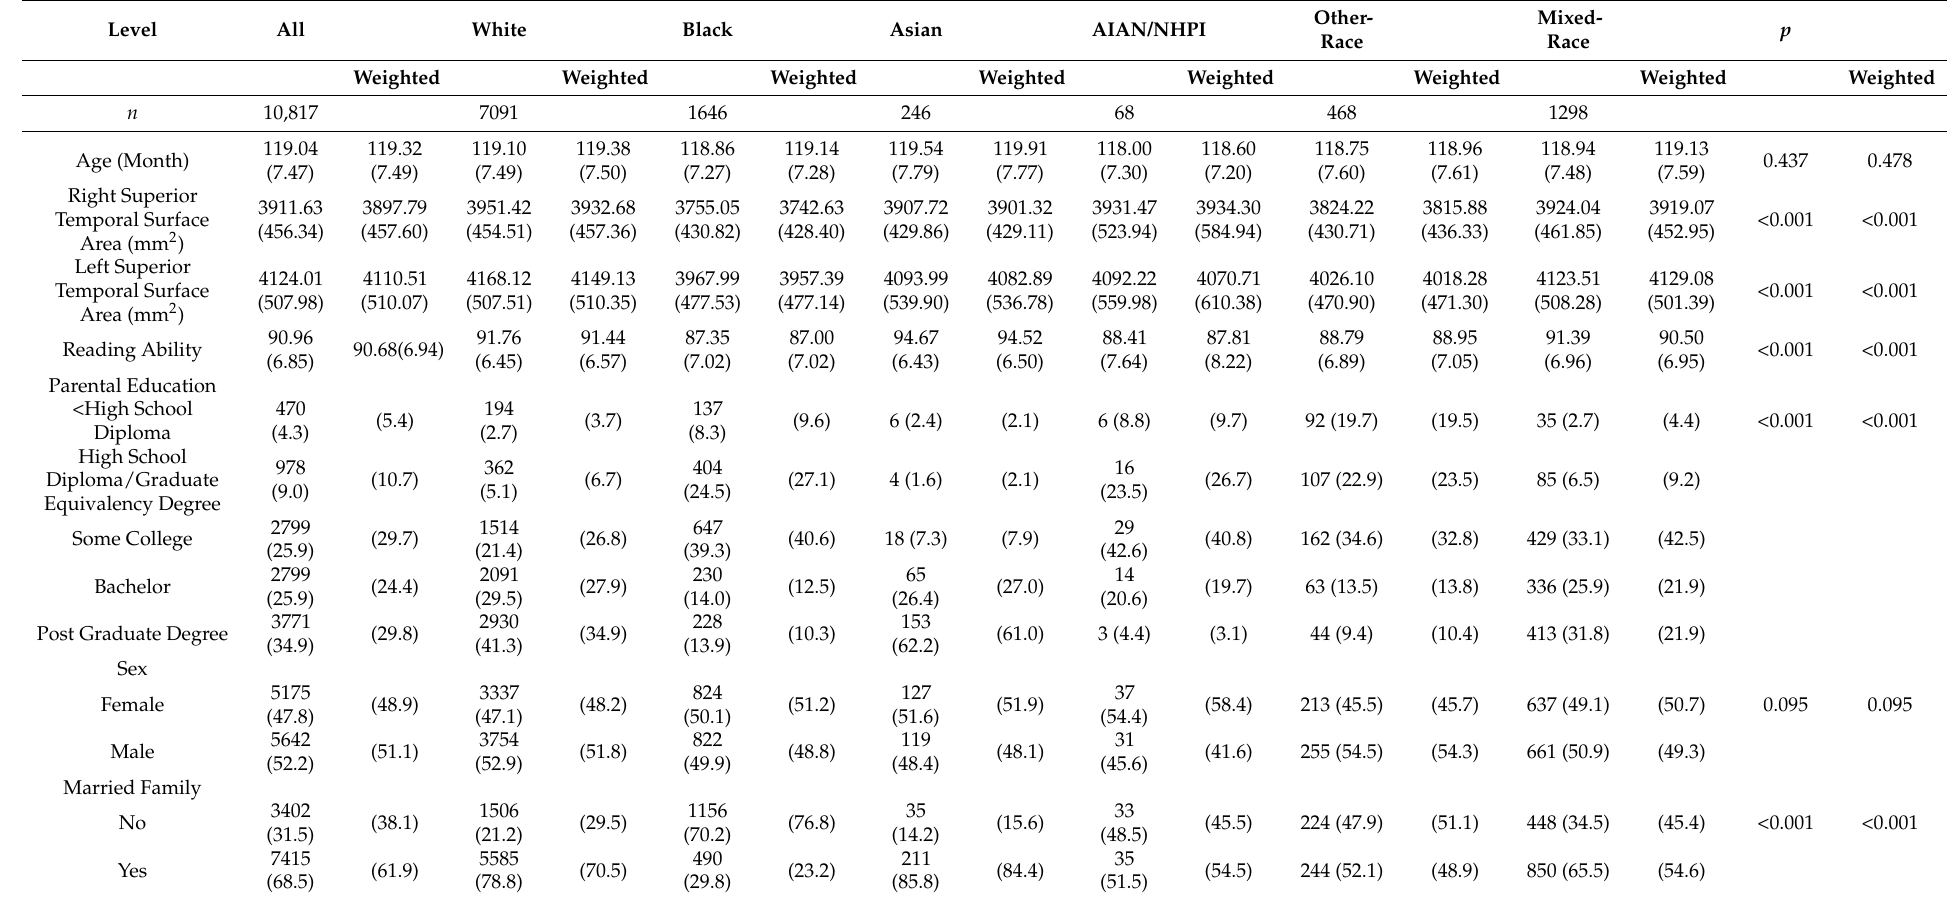
Table 1. Descriptive data for the overall sample and by